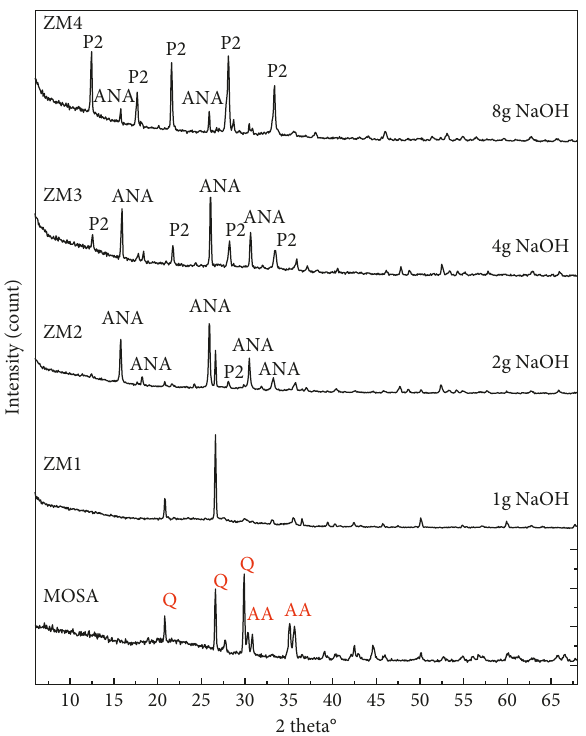
Figure 2: XRD patterns of MOSA and synthesis products. A: augite, Q: quartz, ANA: analcime, and P2: zeolite